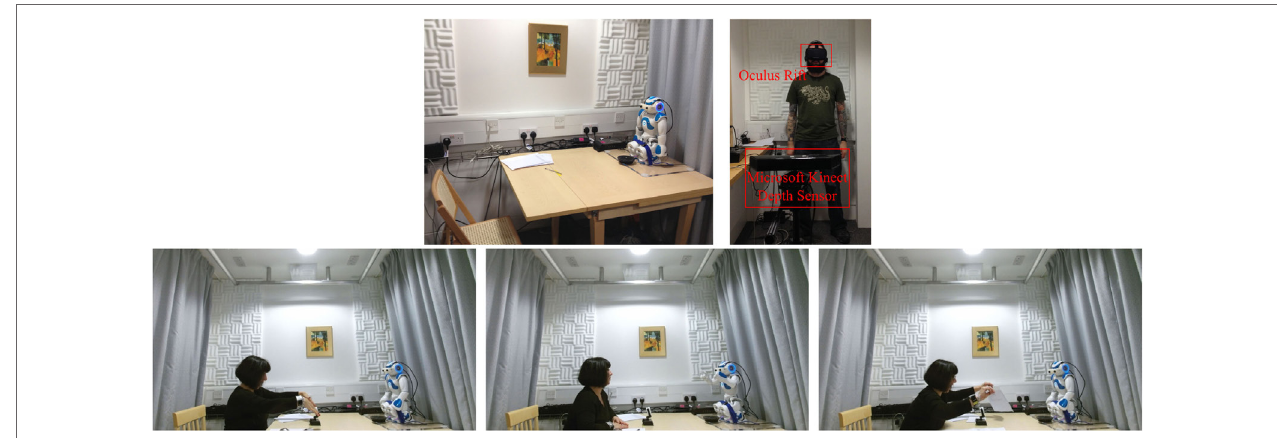
FigUre 2 | snapshots from the Dyadic Tasks study . Upper row: illustration of teleoperation (TO) room and interaction room. Lower row: snapshots from the dyadic interaction